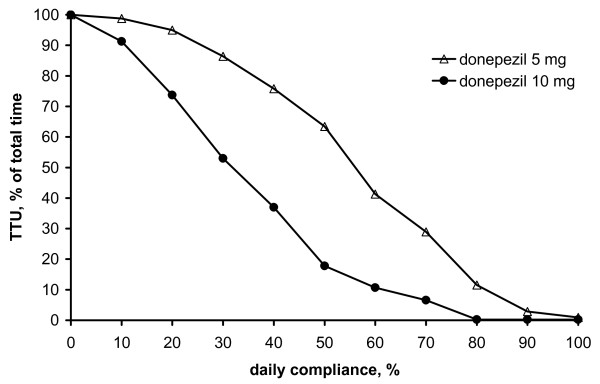
Forgiveness characterisation: Simulation approach B. Time with therapeutic undersupply (TTU) in percentage of total time versus discrete daily compliance values.